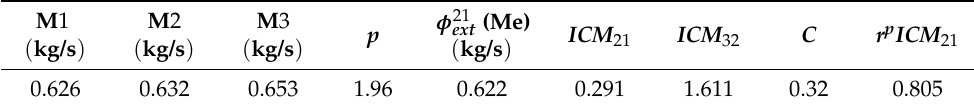
Table 6. Results of the study of mesh convergence for the water mass flow rate at the oil outlet.